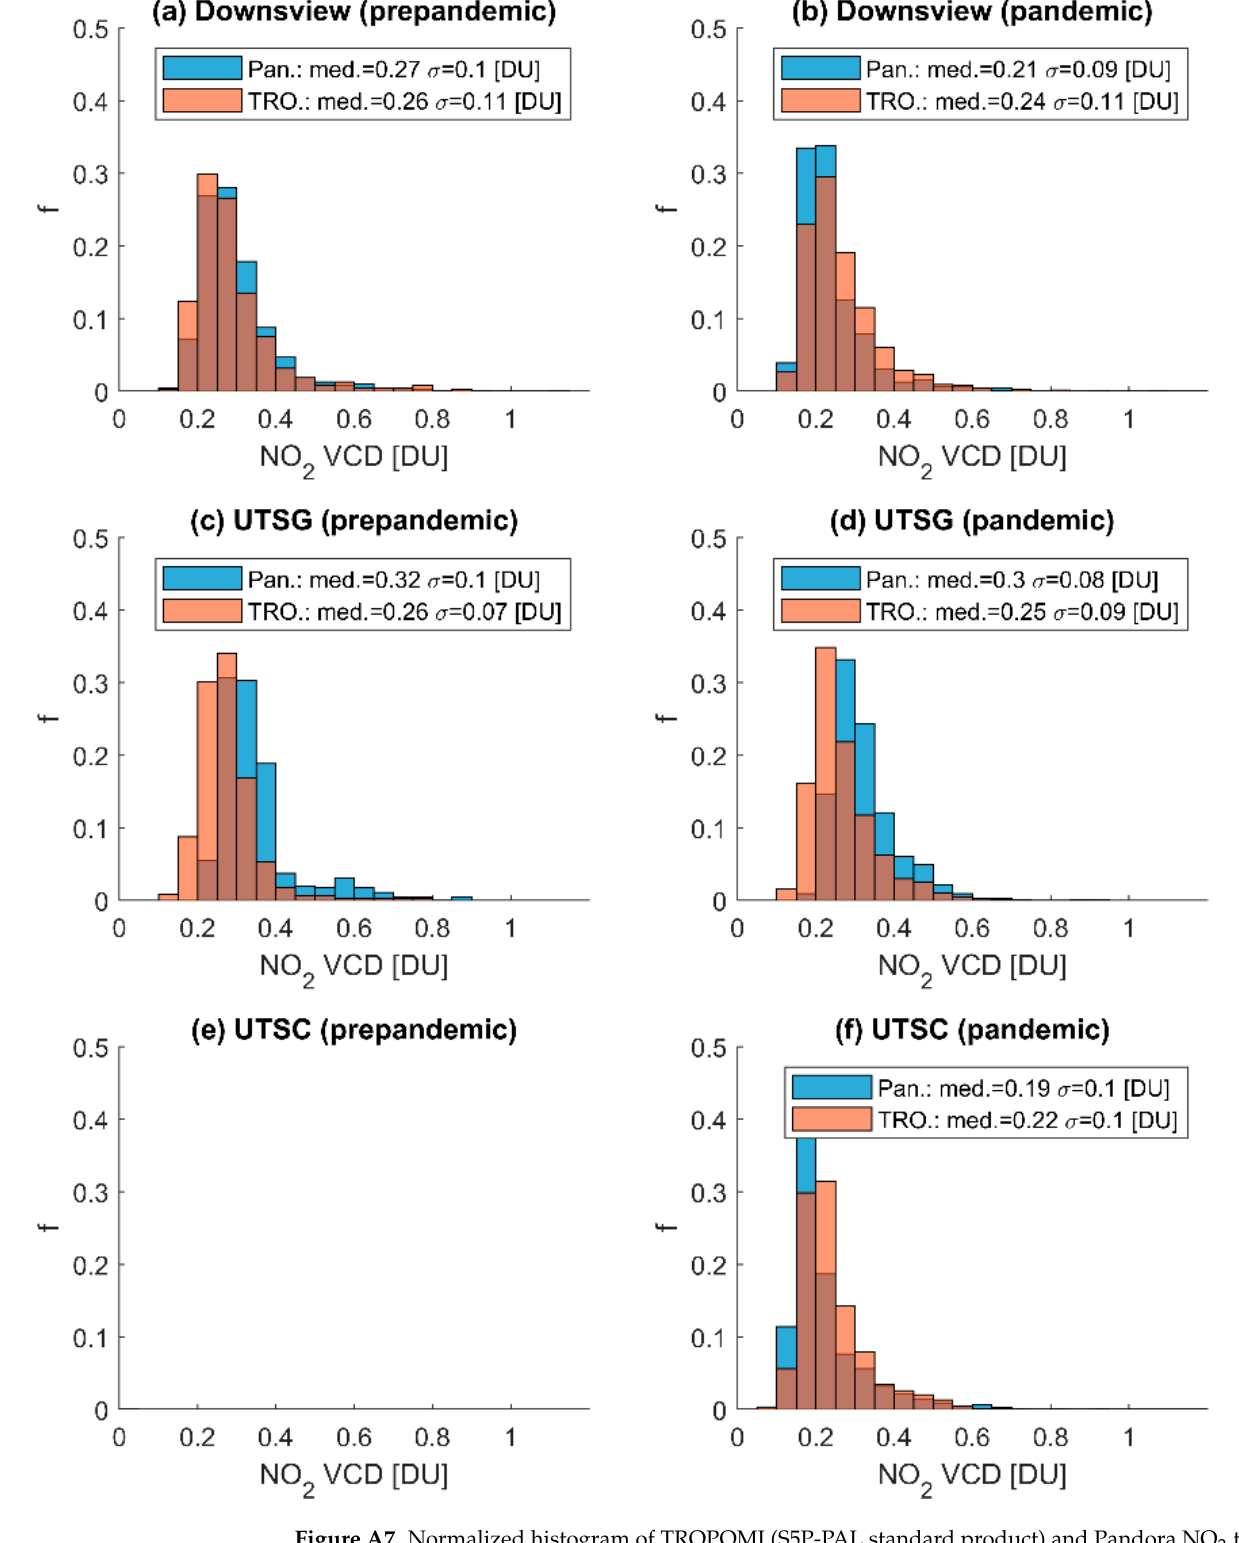
Figure A7. Normalized histogram of TROPOMI (S5P-PAL standard product) and Pandora NO 2 total column (VCD) measurements at Downsview, UTSG, and UTSC, using data from before the pandemic ( a , c , e ) and since pandemic ( b , d , f ). The median and standard deviation of observations are shown in the legends. Pandora measurements taken within ± 1 h around the TROPOMI overpass time were used (observations from 15 March to 15 September for each year).